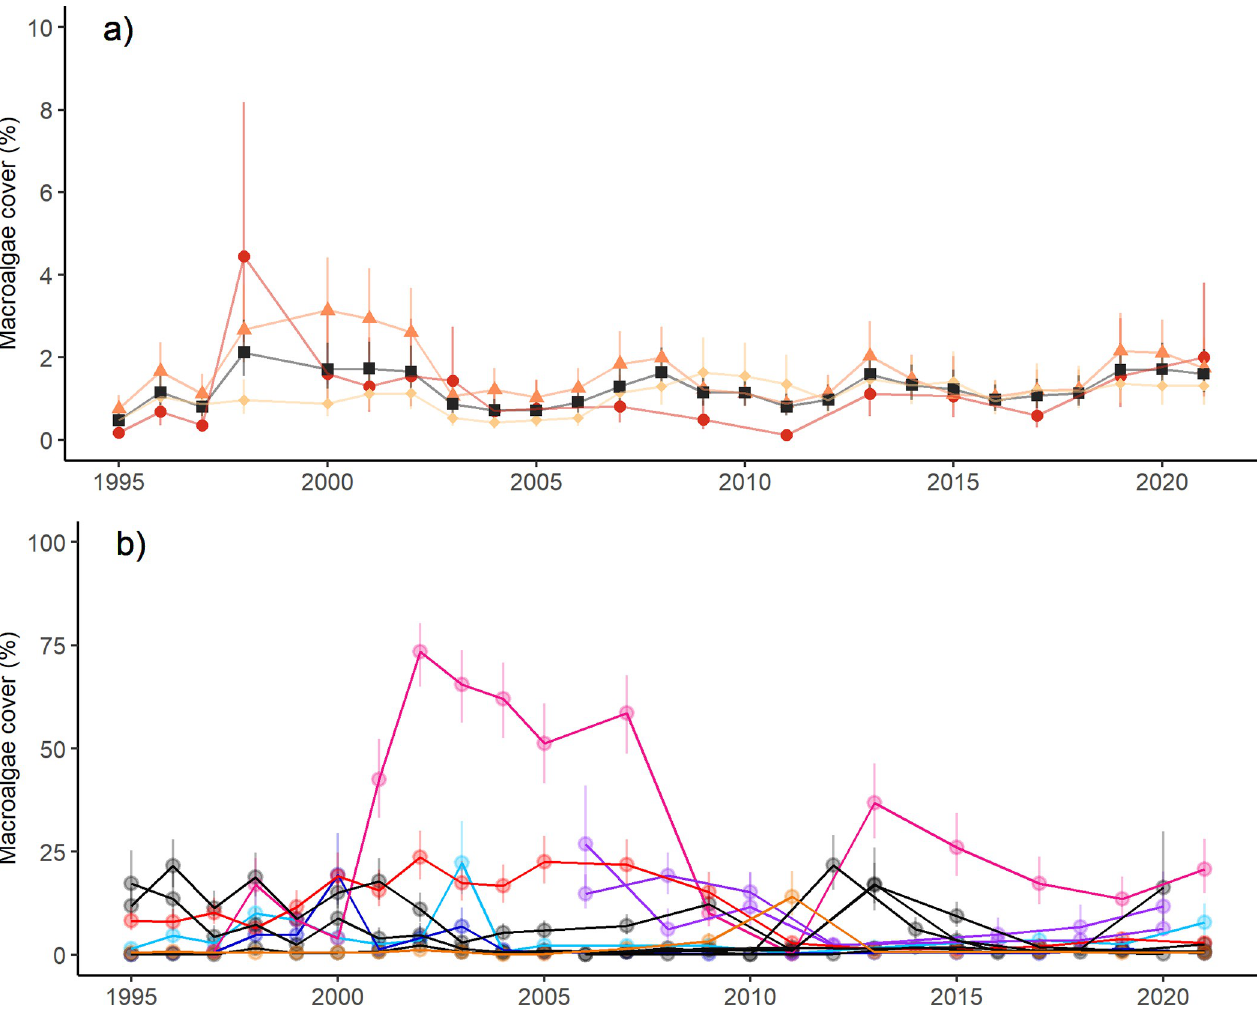
Fig 7. Temporal trend in total macroalgal cover (%) in the Great Barrier Reef between 1995 and 2021. Data are modelled hierarchical posterior distribution means and associated 95% Credible Intervals (CIs) from Bayesian hierarchical linear mixed models. (a) GBR-wide trend (black), as well as the trends for the inshore (red), mid-shelf (orange) and outer-shelf reefs (light orange) reefs. (b) Trends for the 12 reefs with the highest modelled MA values in anyone survey year. Pink: Havannah Reef (Townsville inshore); Light blue: Green Island Reef (Cairns inshore); Dark blue: Low Isles Reef (Cairns inshore); Red: Davies Reef (Townsville mid-shelf); Purple: Central mid-shelf reefs; Grey: Southern mid-shelf reefs; Light orange: Hyde Reef (Whitsunday